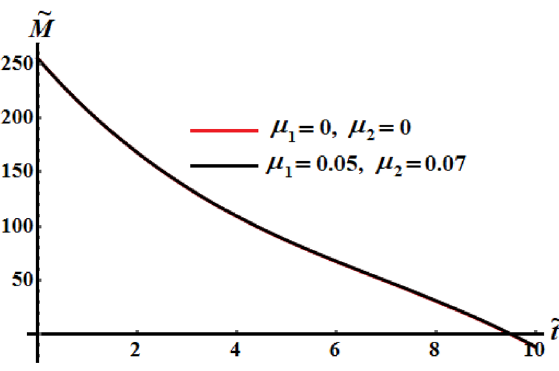
Figure 24. Portrays ˜ M ( ˜ t ) at µ j = 0 ( j = 1, 2 ) , and µ 1 = 0.05, µ 2 = 0.07.